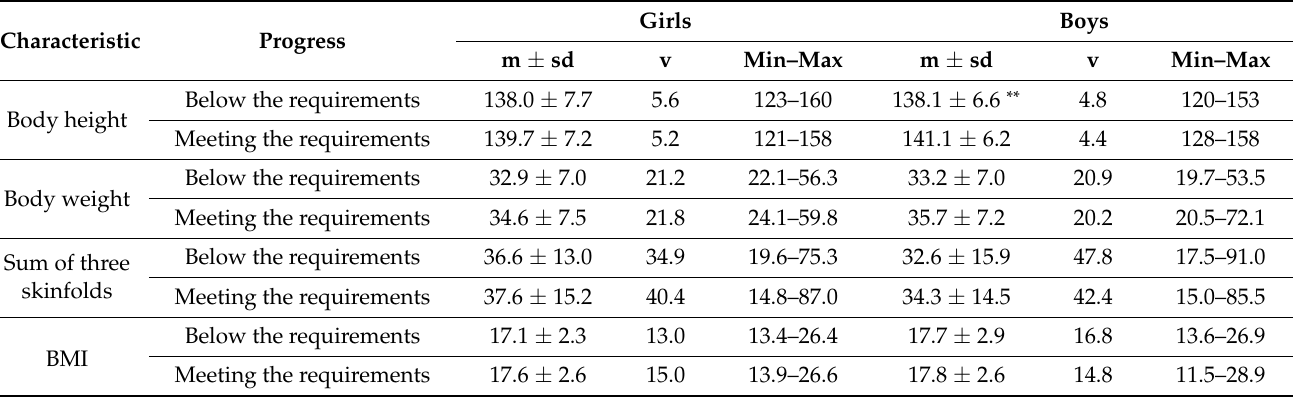
Table 4. Morphological characteristics of 10-year-old children in swimming progress